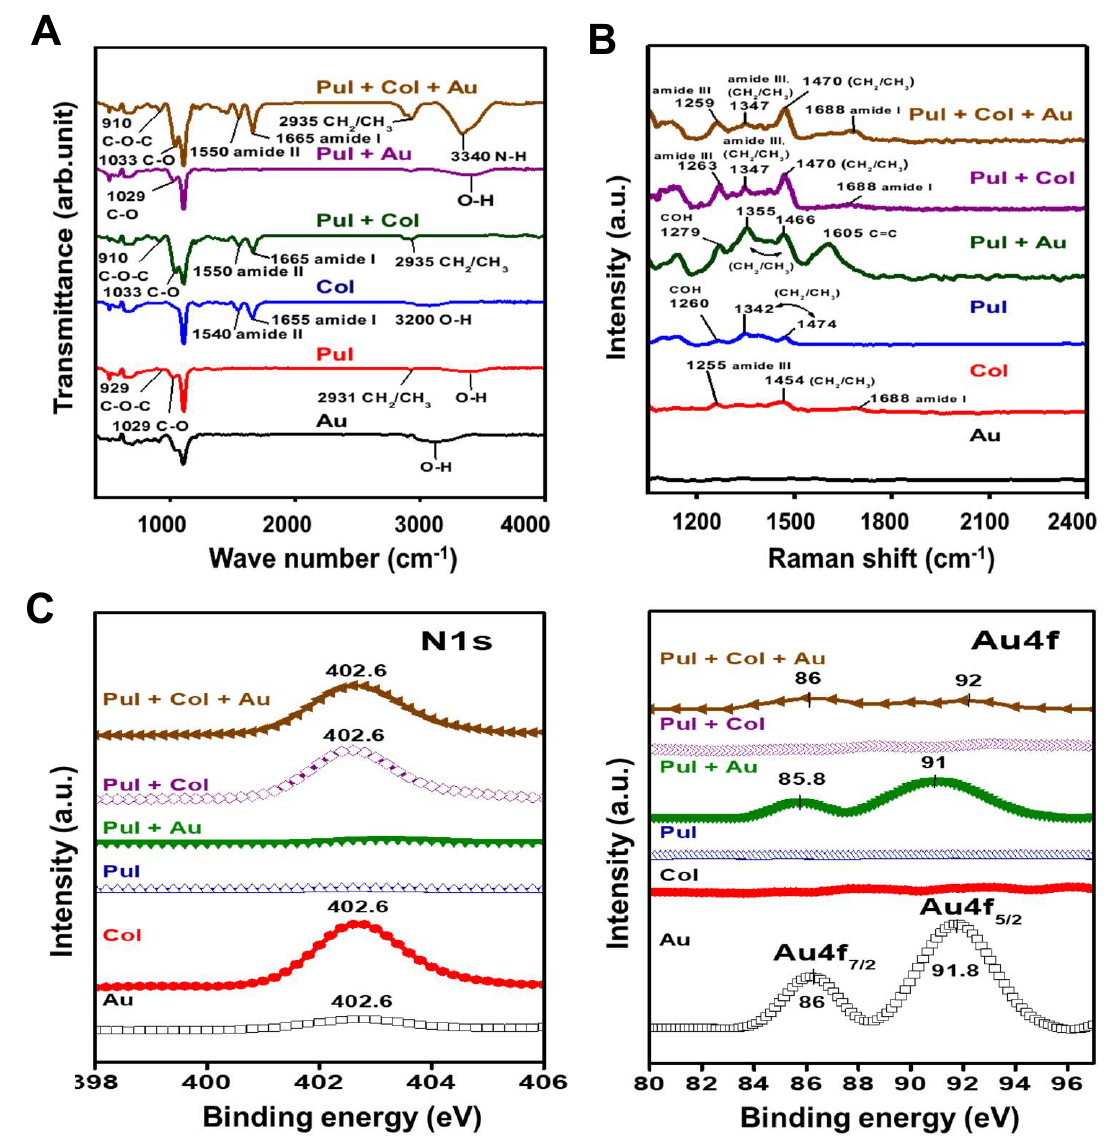
Figure 2. Identification of various nanomaterials by FTIR, SERS, and XPS assay. ( A ) The FTIR spectra evaluated the specific functional groups. The combination of Pul and Col led to the shift of C–O–C vibration from 929 cm − 1 to 910 cm − 1 , C–O vibration from 1029 cm − 1 to 1033 cm − 1 , CH 2 /CH 3 functional group from 2931 cm − 1 to 2935 cm − 1 , and amide II band from 1540 cm − 1 to 1550 cm − 1 . N-H stretching at 3340 cm − 1 was also found in the Pul–Col–Au group, indicating Au nanoparticles successfully bonding with Pul–Col. ( B ) The Raman shift spectra measured in the region from 1100 cm − 1 to 2400 cm − 1 by SERS. The specific absorption peaks of Pul–Col–Au were detected at 1259 cm − 1 (amide III), 1347 cm − 1 (CH 2 /CH 3 ), 1470 cm − 1 (CH 2 /CH 3 ), and 1688 cm − 1 (amide I), indicating the presence of Pul, Col, and Au. ( C ) The wide-scan XPS spectra of various nanomaterials. The combination of Pul and Col shows the N1s peak position at 402.6 eV binding energy due to the amide group in Col. The binding energy of Au at 86 and 91.8 eV was detected in Pul–Col–Au, indicating the structure of Pul–Col would not change by the addition of Au.